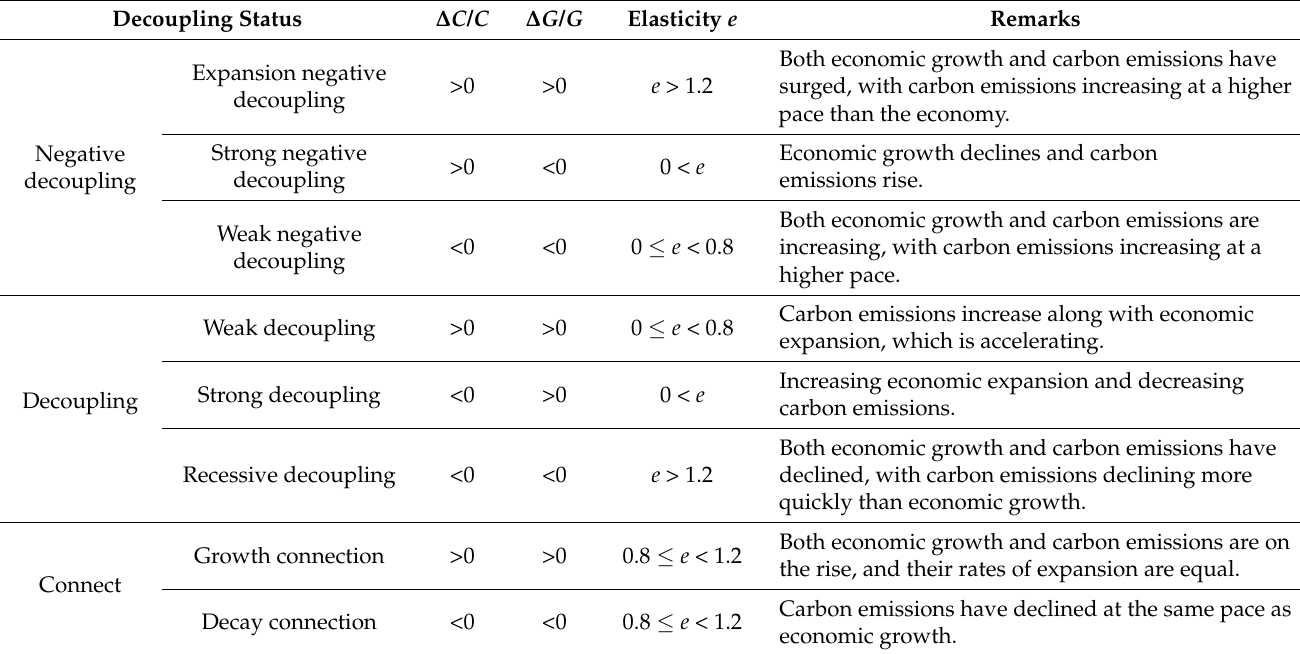
Table 2. Indicators and descriptions of eight decoupling